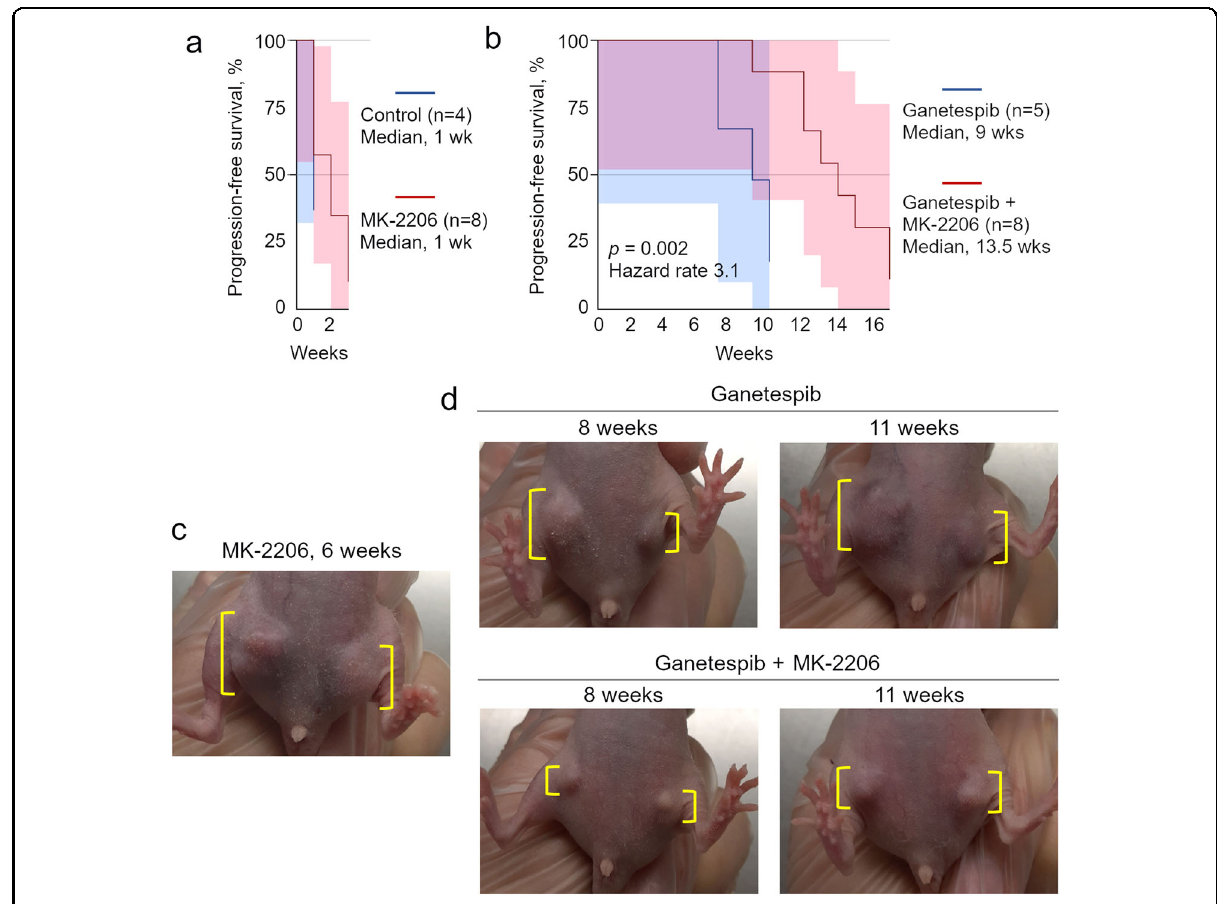
Fig. 4 Akt inhibition signi fi cantly delays Ganetespib resistance in vivo. Immunode fi cient female recipients were allografted with primary tumor cells from Neu mice into mammary fat pads and upon tumor onset, received either no drug (Control), a pan-Akt inhibitor MK-2206 alone, Ganetespib alone, or both (Ganetespib + MK-2206). The initial tumor size (when treatments started) was comparable for all four groups and was 87 ± 31 mm 3 , 88 ± 9 mm 3 , 90 ± 20 mm 3 , 91 ± 20 mm 3 (mean± SEM), respectively. a , b Progression-free survival comparing the indicated cohorts. Kaplan – Meier analysis, Log Rank statistics ( p ). Shaded areas are 95% con fi dence interval. c , d Representative tumors at the indicated time after treatment initiation. Note a signi fi cantly smaller tumor size in the mice treated with combined Ganetespib + MK-2206 compared with Ganetespib alone or MK-2206 alone (yellow